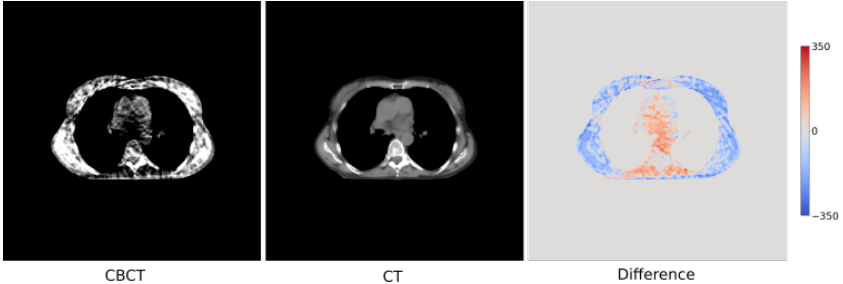
Figure 2. CBCT ( left ) and CT ( middle ) scans for a randomly chosen patient. Differences between the two scans with a HU range of [ − 300, 300] are also shown ( right